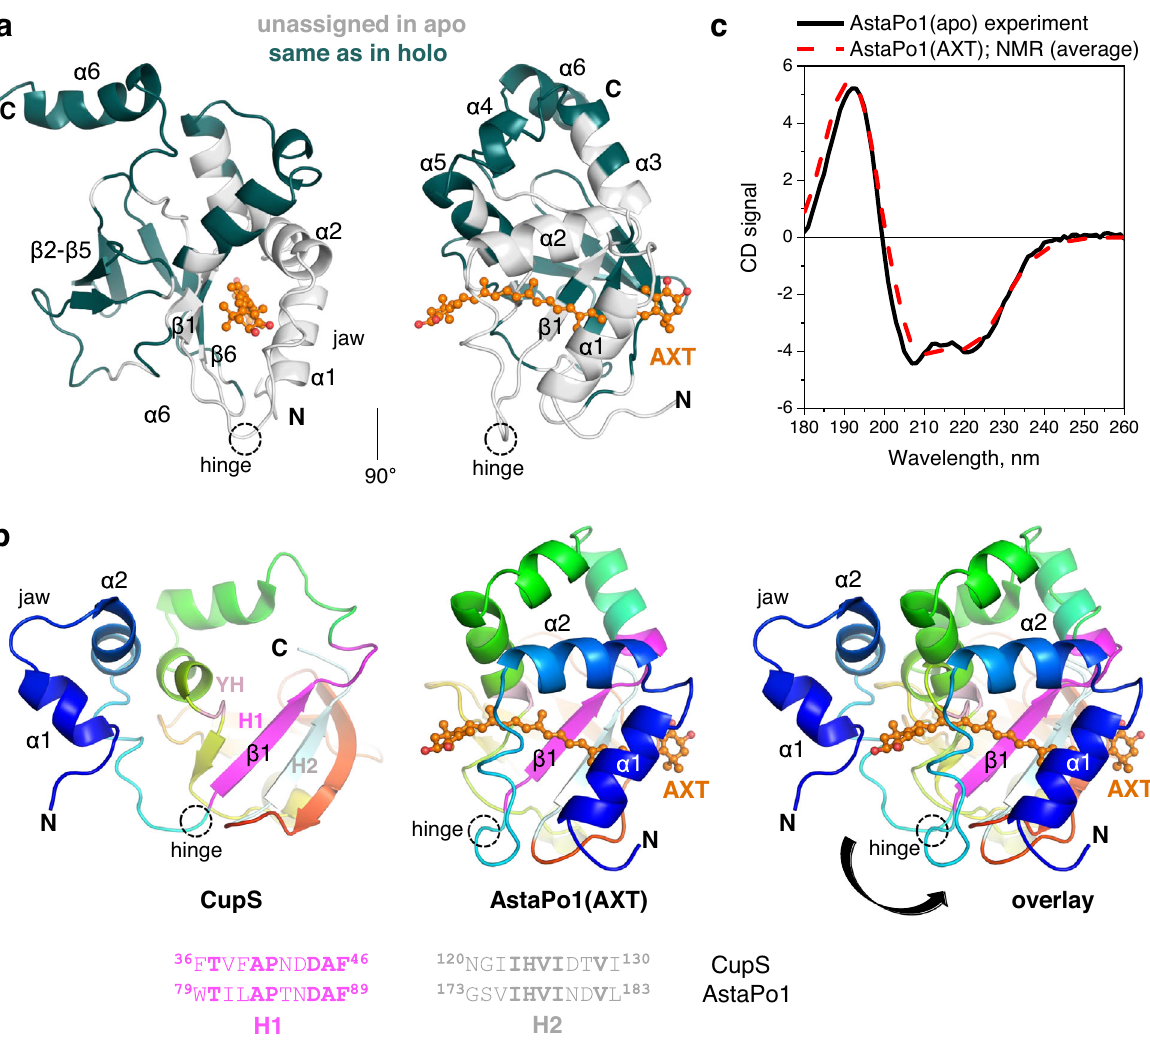
Fig. 4 Insights into the carotenoid capture mechanism by AstaPo1. a Structure of the AstaPo1(AXT) complex is colored according to the NMR data obtained for the apoform. Regions with known NMR chemical shifts, which reveal the identical structure with the AstaPo1 holoform, are colored green (Supplementary Fig. 10), and the other parts of the protein, for which no assignment could be obtained, are colored light gray. b A hypothetical carotenoid capture mechanism. Three panels represent from left to right: the CupS FAS1-containing protein (PDB ID: 2MXA 7 ) in a tentative “ open-like ” conformation, AstaPo1 in complex with AXT (our NMR structure), and their overlay. The structures are colored by a gradient from blue (N) to red (C), except for the conserved motifs used for structural alignment — H1 (magenta), H2 (pale cyan), and YH (pale pink). The pairwise sequence alignment of the H1 and H2 fragments is shown below (identical residues are in bold font). AXT is shown as an orange ball-and-stick model, the main secondary structure elements and the hinge loop are labeled. The proposed conformational transition from an open to a carotenoid-bound state is depicted by the arrow. c Far UV CD spectrum of the AstaPo1 apoform (black line) is shown overlaid with the average CD spectrum calculated from 20 NMR models of the holoform of the same construct (red dashed